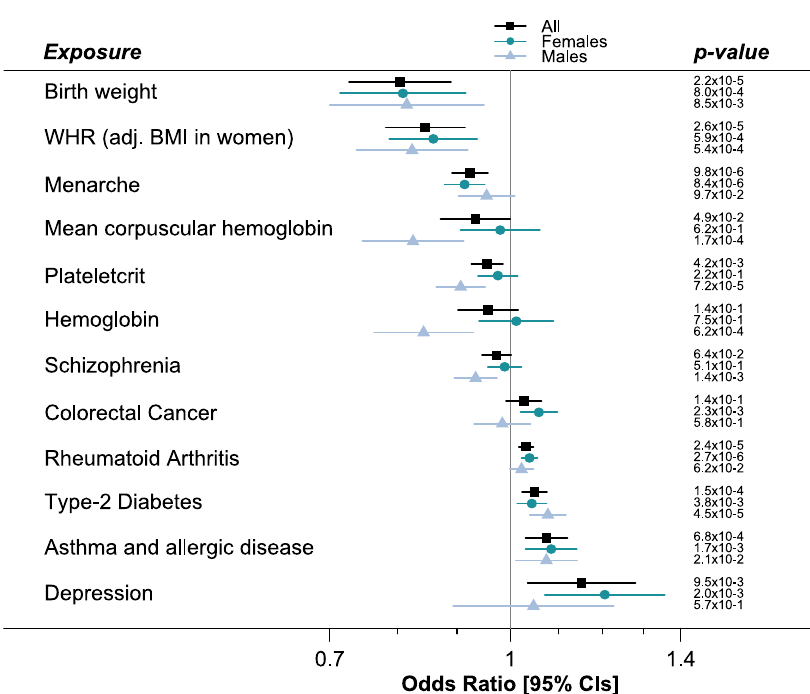
Fig. 3 Traits sharing causal pathways with low grip strength at older ages identi fi ed in Mendelian Randomization analysis. In Mendelian randomization analyses we estimated whether 83 exposures may share causal pathways with low grip strength in people aged 60 and older. Those identi fi ed as signi fi cant (multiple testing-adjusted p < 0.05) in at least one analysis (all participants, or males or females separately) are included in the fi gure. *WHR (adj. BMI in Women) = Waist-Hip Ratio SNPs identi fi ed in GWAS analysis of females only, adjusted for Body Mass Index. N = meta-analysis of 256,523 Europeans (biologically independent samples) aged 60 or older from 22 cohorts. Data presented as Odds Ratios + / − 95% Con fi dence Intervals. Unadjusted p value (two-sided) from IVW regression analysis of exposure SNPs effect on low grip strength (EWGSOP de fi nition). Full results of Mendelian randomization available in Supplementary Data 11, 12 and